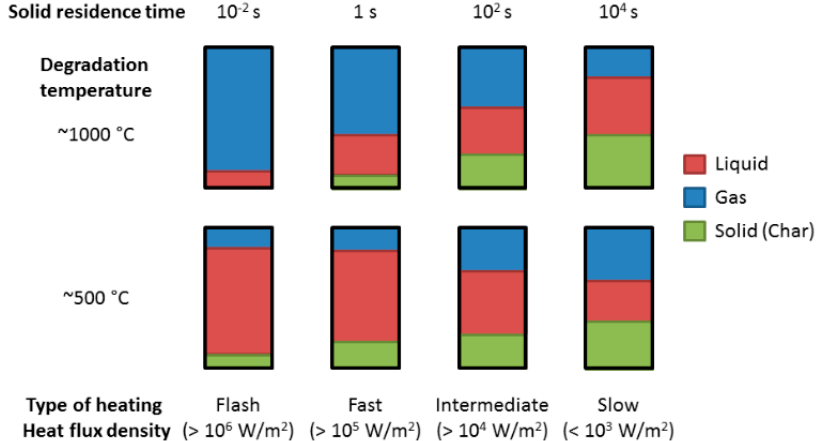
Figure 1. Pyrolysis technologies classification (Adapted from [9]).